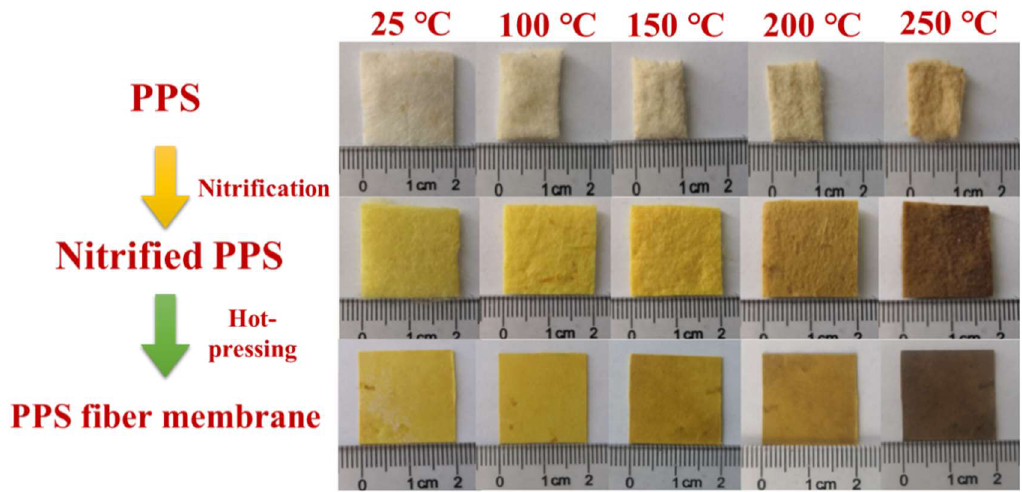
Figure 9. High-temperature resistance experiment diagram of PPS matrix.